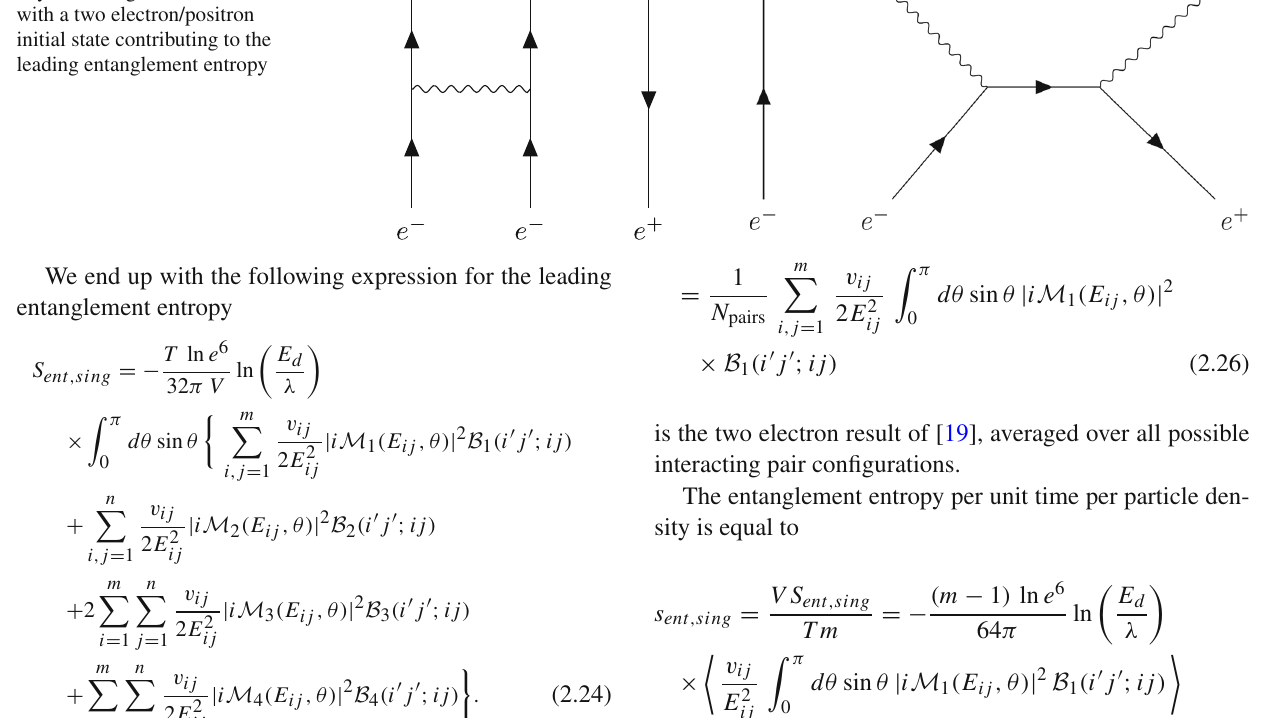
Fig. 1 Non-trivial disconnected Feynman diagrams associated with a two electron/positron initial state contributing to the leading entanglement